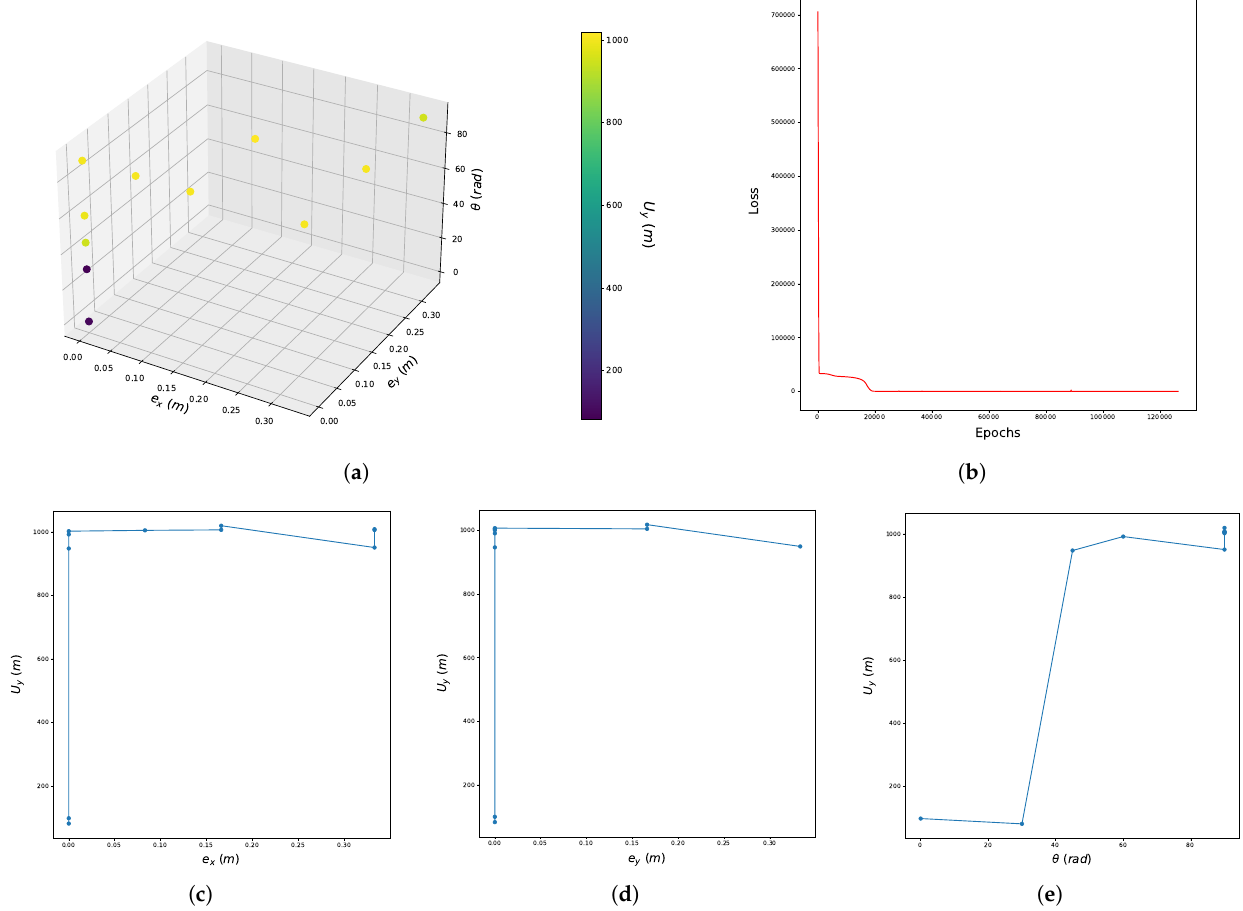
Figure 12. Graphical presentation of the Neural Network that corresponds to Monte Carlo analysis S - κ L - c R -d3 (NND3) for the estimation of the deviatoric component of the stress q dev in kPa. ( a ) 3D representation of the Neural Network. ( b ) Epochs-Loss diagram. ( c ) Neural Network representation in the projection of the input axis of e x . ( d ) Neural Network representation in the projection of the input axis of e y . ( e ) Neural Network representation in the projection of the input axis of θ